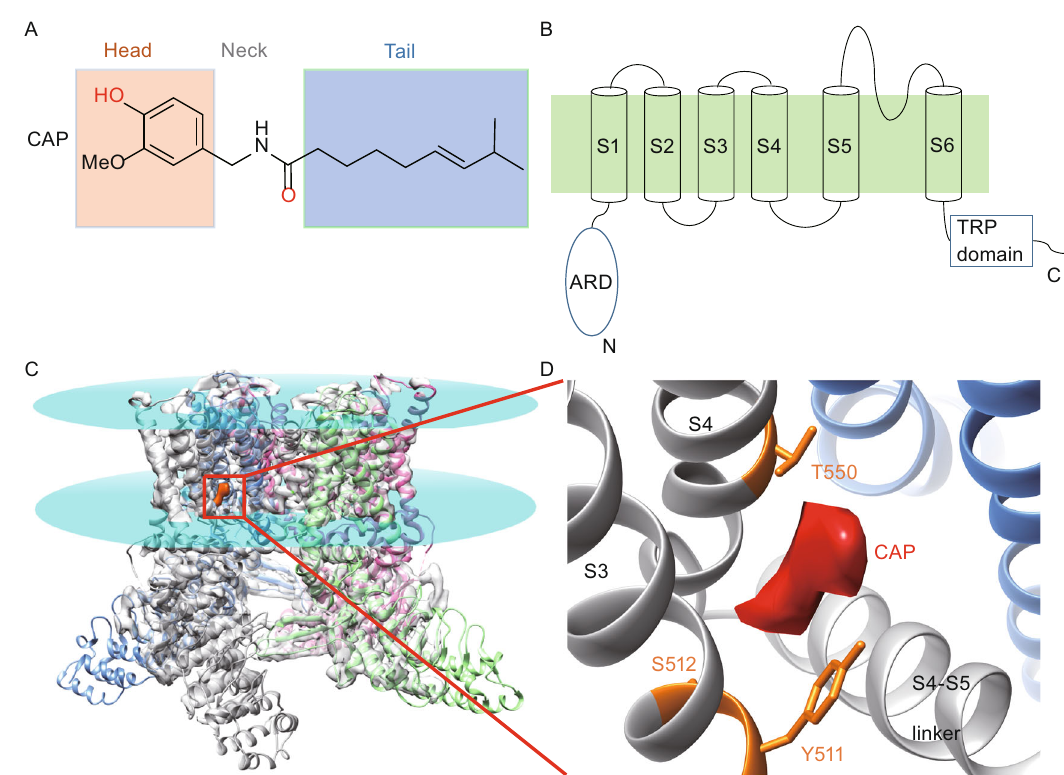
Figure 1. Capsaicin and TRPV1. (A) Chemical structure of capsaicin. The vanillyl Head and hydrophobic Tail groups are shaded in orange and blue, respectively. The atoms forming hydrogen bonds with TRPV1 are highlighted in red. (B) Schematic diagram showing the topology of a TRPV1 subunit. Membrane is shaded in green. (C) High resolution structure of rat TRPV1 determined by cryo-EM (atomic model: 3J5R in PDB; electron density map, 5777 in EMD). It is clear that capsaicin (electron density boxed by solid line) binds to the transmembrane domains. Lipid membrane boundaries are indicated by cyan disks. (D) A zoom-in view of the capsaicin binding pocket. Residue important for capsaicin activation identi fi ed by mutagenesis and functional studies are colored in orange. The electron density of capsaicin is colored in